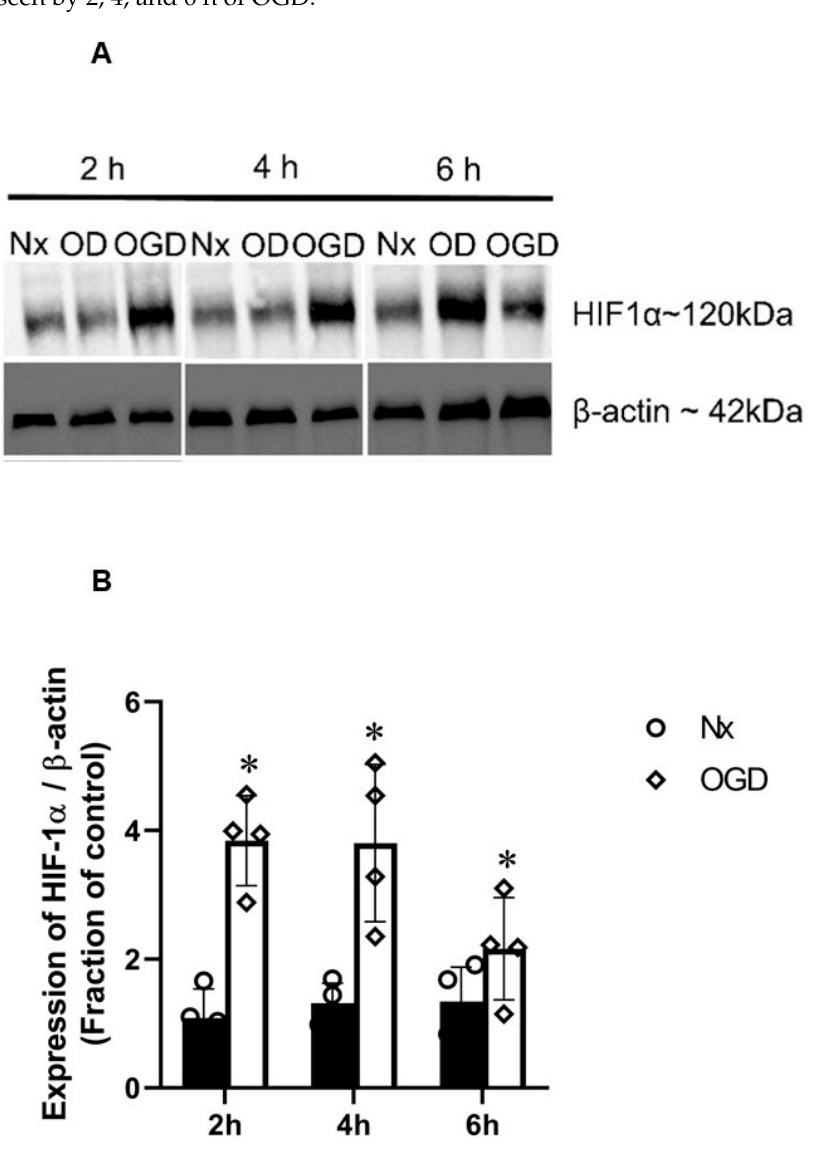
Figure 9. HIF-1 α protein stabilisation by oxygen–glucose deprivation (OGD) in primary rat cortical neurons. ( A ) Representative Western blots of HIF-1 α and corresponding β -actin of cells exposed to 2, 4, and 6 h of OGD. The protein levels were quantified by densitometric analysis using Image J. Values were normalised to β -actin and corresponding Nx control (Figure S2). ( B ) Graph ( n = 4) showed the normalised HIF-1 α level measured after 2, 4, and 6 h OGD. There was significant higher HIF-1 α / β -actin ratios by OGD (2, 4 and 6 h) treatments compared to Nx controls. Error bars represent ± S.D. * Indicates p < 0.05 against Nx controls.